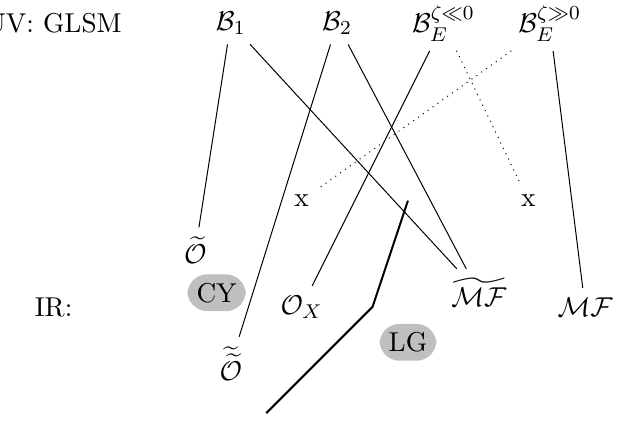
Figure 2 . Di(cid:11)erent GLSM branes can map to the same objects in a phase. phase, while B (cid:16) (cid:28) 0